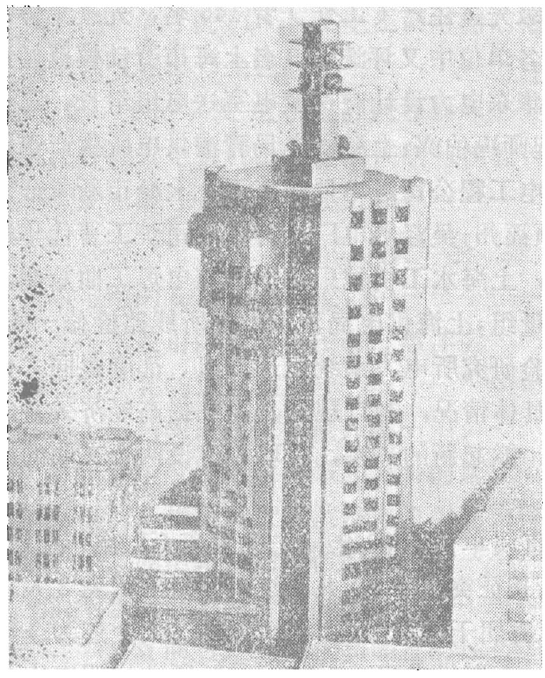
Fig. 3 Model of the SECEP Building during the design process (Source: Yang